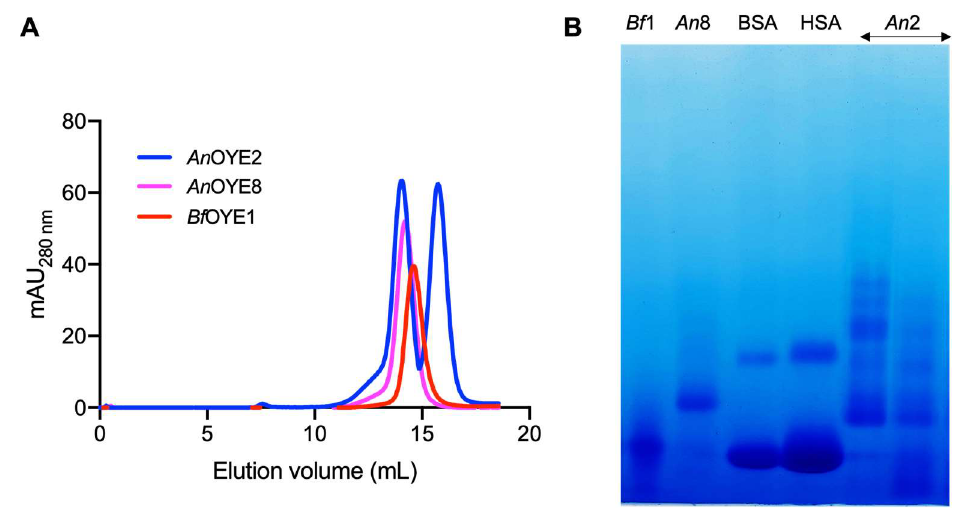
Figure 2. Analytical gel filtration of purified protein samples (150 µg) eluted from a Superdex 200 10/300 GL column ( A ) and blue native gel (BN-PAGE) of samples (12.5 µg) from each observed peak ( B ). BSA = bovine serum albumin (25 µg); HSA = human serum albumin (30 µg).